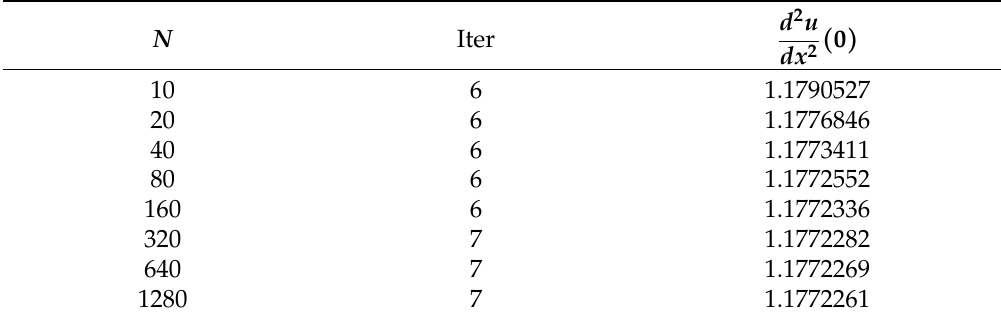
d 2 u ( 0 ) for different values of N . dx 2